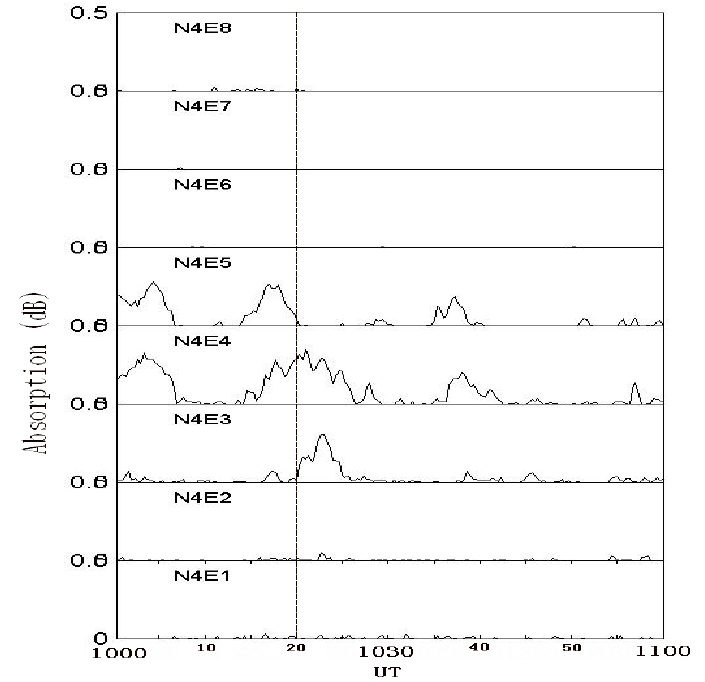
Fig. 7. Absorption intensities for different imaging riometer channels at Zhongshan Station between 10:00 and 11:00 UT on 10 September 2002. Table 3. The times that each spacecraft (TC-1, TC-2 and CL-1) is in conjunction with ZHS/NAL, listed according to magnetic local